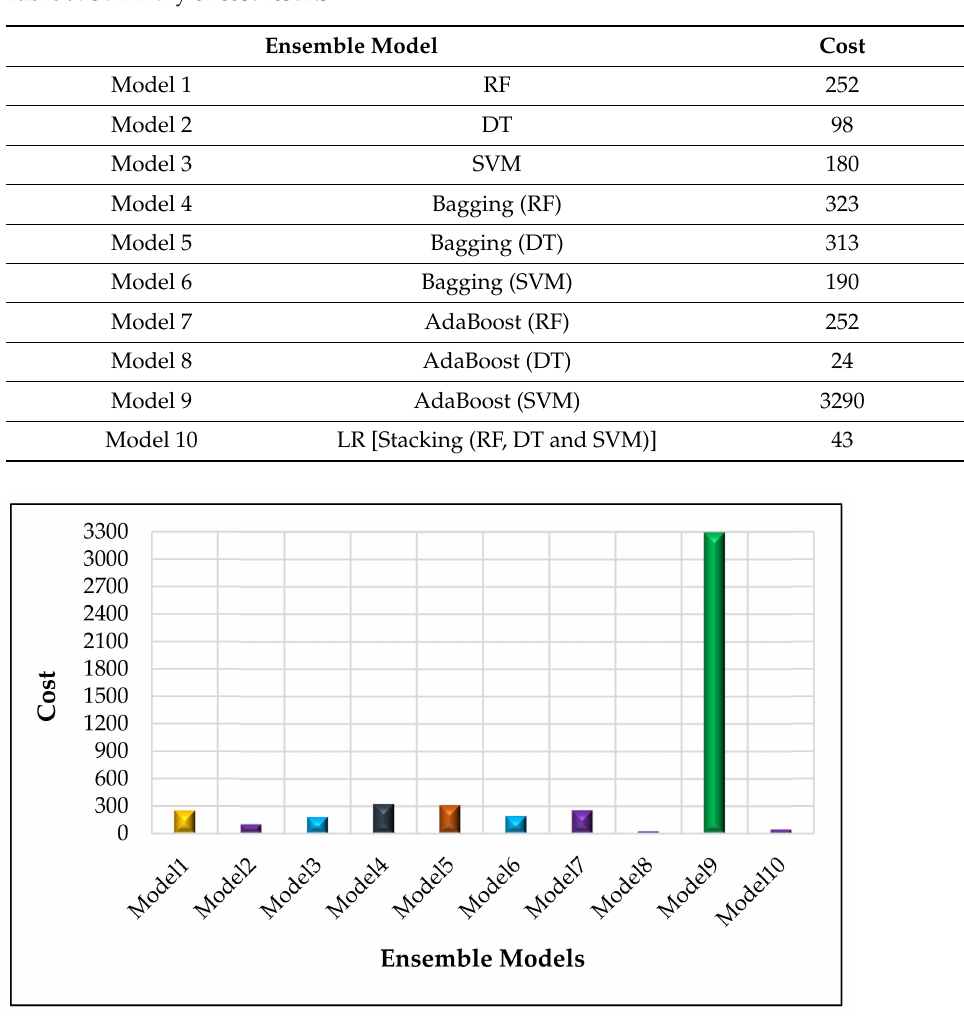
Figure 5. The model cost results: cost of RF, DT, SVM, bagging, AdaBoosting, and stacking as shown in the x-axis: Model 1—RF, Model 2—DT, Model 3—SVM, Model 4—Bagging (RF), Model 5—Bagging (DT), Model 6—Bagging (SVM), Model 7—AdaBoosting (RF), Model 8—AdaBoosting (DT),